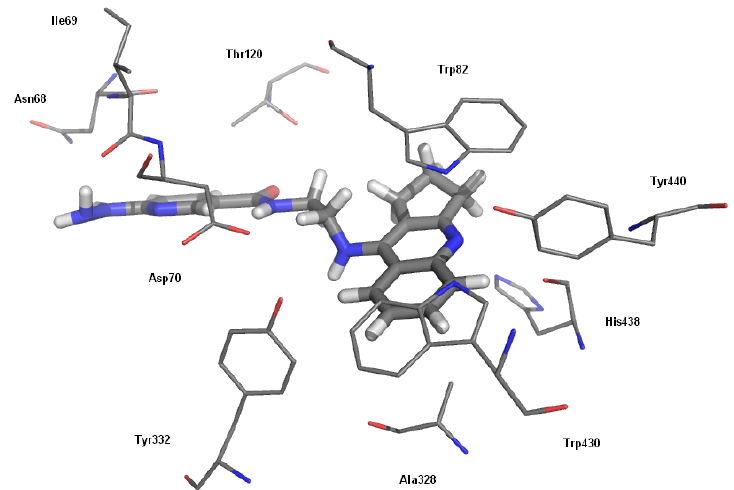
Figure 2. Binding mode of compound 6a with butyrylcholinesterase.